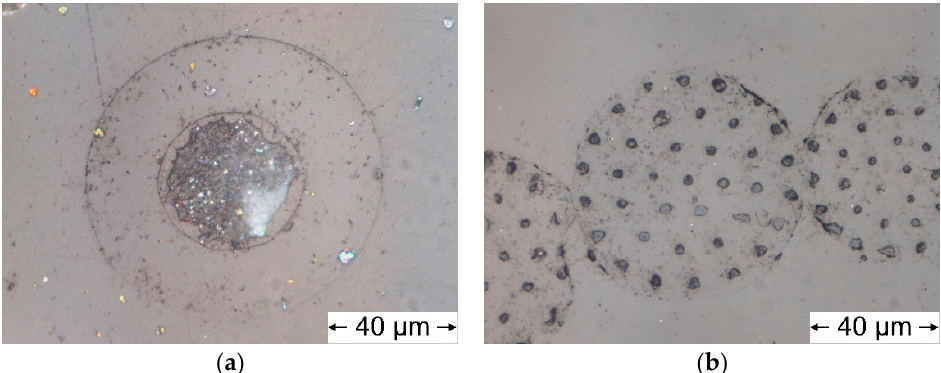
Figure 2. Microscopy images of TPU / PCL core-sheath ( a ) and island-in-sea ( b ) type with the PCL component stained in blue.